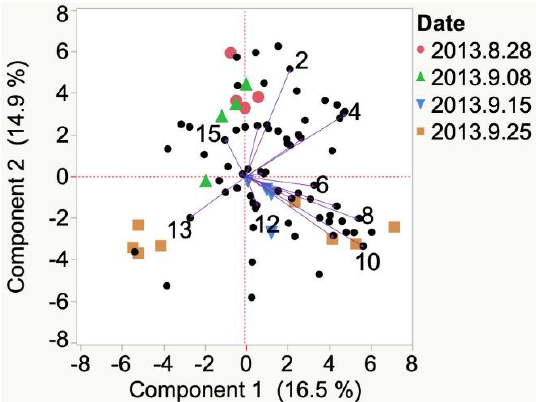
Figure 11. Evolution of VOCs emitted from crushed berries from veraison to harvest of 2013 St. Croix grapes grown in South Dakota. Key to most representative volatiles from HCA, shown as vectors from the origin and read clockwise: 1 = Benzyl alcohol, 2 = Benzaldehyde, 3 = Octanal, 4 = Acetophenone, 5 = Linalool, 6 = Ethyl acetate, 7 = Methyl salicylate, 8 = Safrol, 9 = Propionaldehyde, 10 = 2-Phenylethanol, 11 = 1-Pentanol, 12 = 2-Heptanone, 13 = Benzoic acid, methyl ester, 14 = Aspirin methyl ester, 15 = N -benzyl-2-phenethylamine.